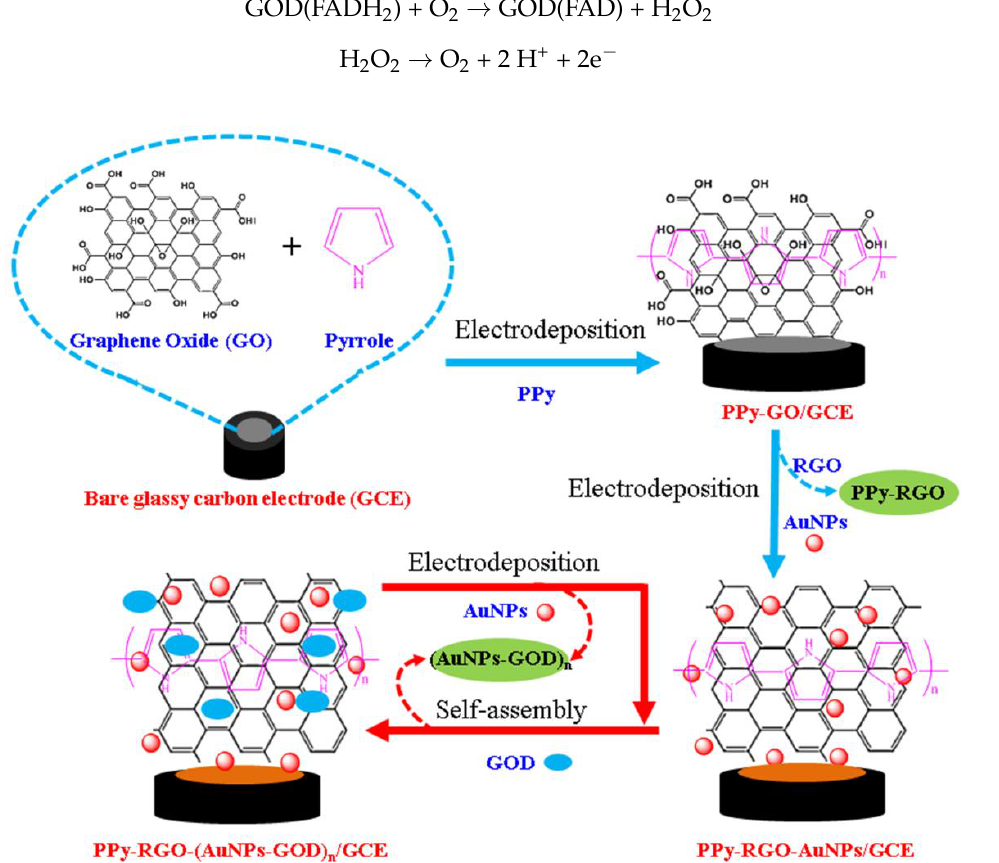
Figure 1. Schematic illustration of a glucose biosensor using the polypyrrole and reduced graphene oxide (PPy-RGO), and gold nanoparticles and glucose oxidase (AuNPs-GOD) multilayer films as the sensitive layer fabricated by the electrodeposition and self-assembly.